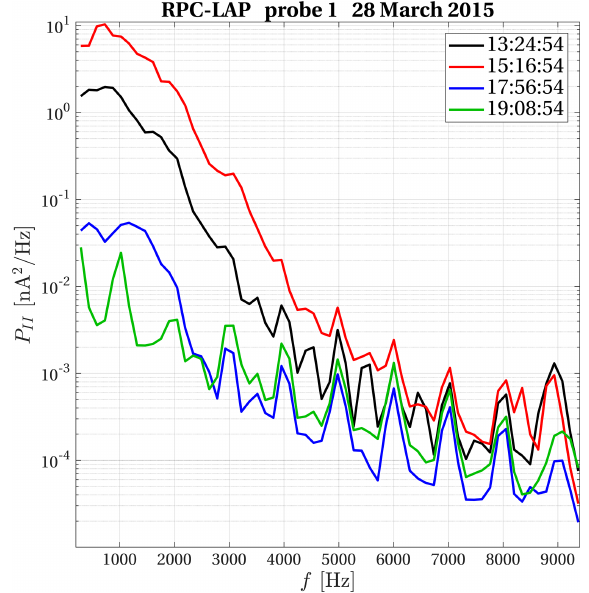
Figure 3. Power spectral densities from 200Hz up to the Nyquist frequency for the RPC-LAP probe 1 current for four different times during the Rosetta close flyby of comet 67P. The black curve (13:24:54) is used in Sect. 3 for analysis of waves near closest ap- proach and the blue curve (17:56:54) for similar analysis of during the outbound part of the